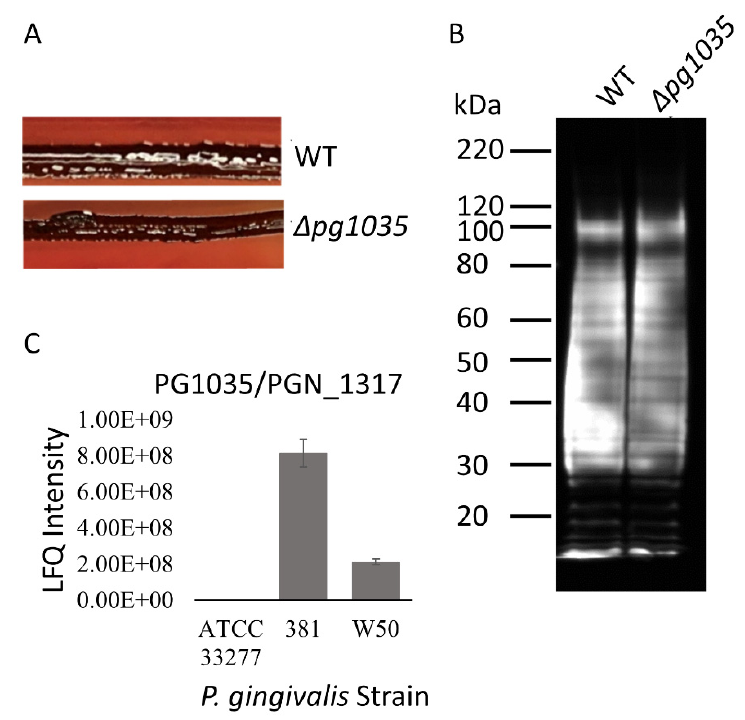
Figure 4. PG1035 is a nonessential component of the T9SS . ( A ) Black pigmentation of the WT and ∆ pg1035 deletion mutant on blood agar plate after 7 days. ( B ) Proteins in the whole cell lysates of the WT and ∆ pg1035 deletion mutant were electrophoresed on an SDS-PAGE gel. The proteins were transferred onto a membrane and probed with mAb-1B5 (anti-A-LPS) antibodies. ( C ) Expression levels of PG1035 (ATCC 33277 PGN_1317) in different P. gingivalis strains measured by mass spec- trometry and quantitated by MaxQuant.